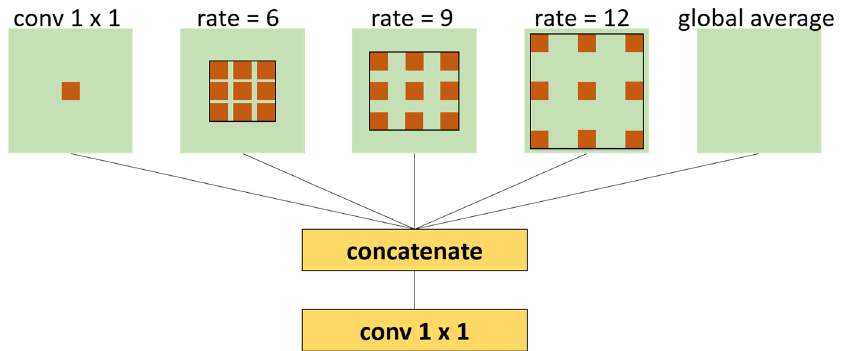
Figure 6. Atrous convolution in a network.